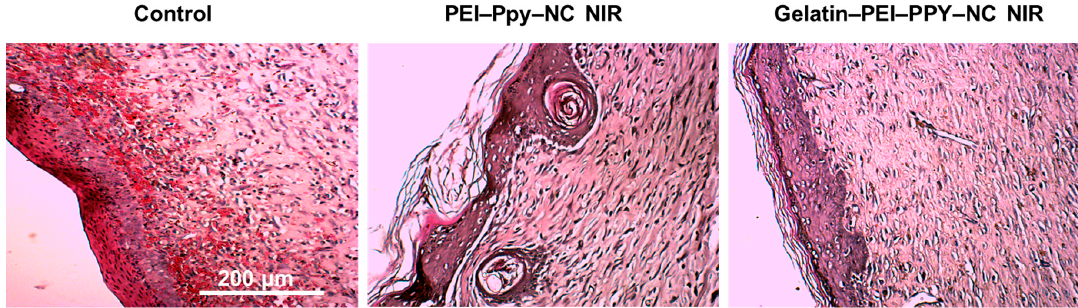
Figure 9. Histological findings from the untreated control and experimental groups’ wound site skin tissue at three weeks of wound healing.